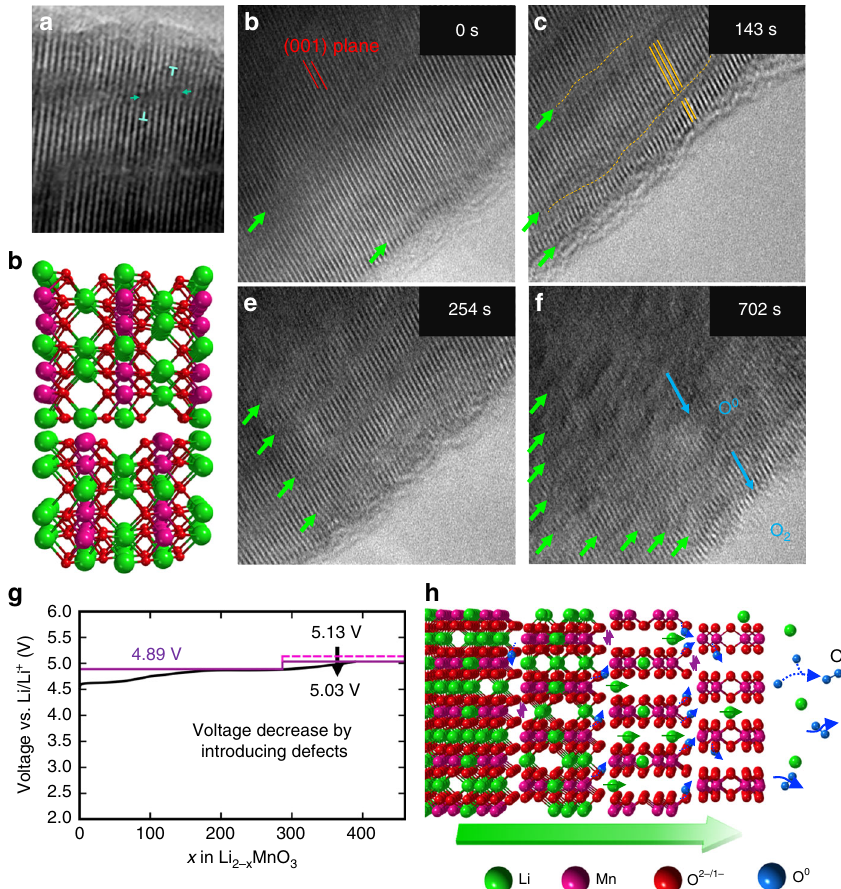
Fig. 2 The form and motion of the second kind of defects upon delithiation. a Dissociated dislocation in Li 2 MnO 3 with Burgers vector c /2[001] formed dynamically in delithiation. b Atomic model of the dislocation containing lithium vacancies in both Li- and Li-Mn layers. c – f Defect density (green arrowheads) of the Li 2 MnO 3 electrode increases as the delithiation process progresses. g Comparison of experimental voltage – composition plot of a Li/Li 2 MnO 3 cell (black) with the calculated plot of cells containing Li 2 MnO 3 electrodes with b /6[110] defects dominating the fi rst step (4.89 V) and c /2[001] defects dominating the second step (5.03 V). Without the c /2[001] defects, the second step would occur at voltage of 5.13 V. h Illustration of the c /2[001] defects and a proposed mechanism by which oxygen is transported in a highly defective Li 2 MnO 3 electrode structure and released at the surface